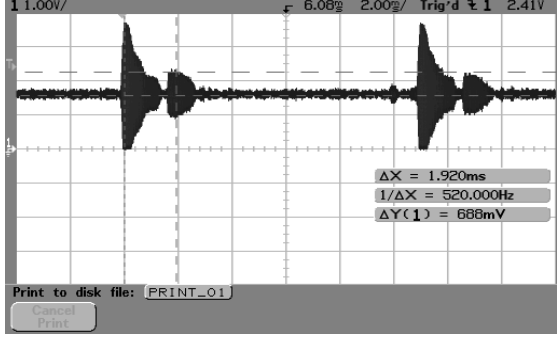
Figure 27 . Main and delayed (and